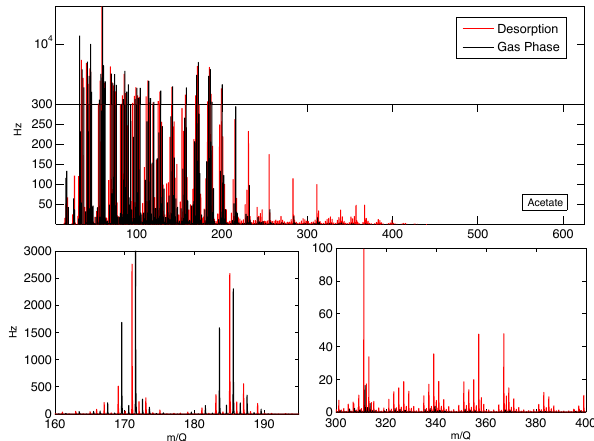
Fig. 2. Example spectra from ozonolysis of α -pinene from the UW- Seattle chamber. Thermal desorption data are shown in red, using the average desorption signal for one collection. The gas signal is shown in black shifted to the right by 0.5amu for clarity. The lower panels show zoomed in regions of the spectra: common major acid products from the α -pinene + ozone reaction (left) and highly oxy- genated, large molecular weight compounds which are predomi- nantly found in the particle phase